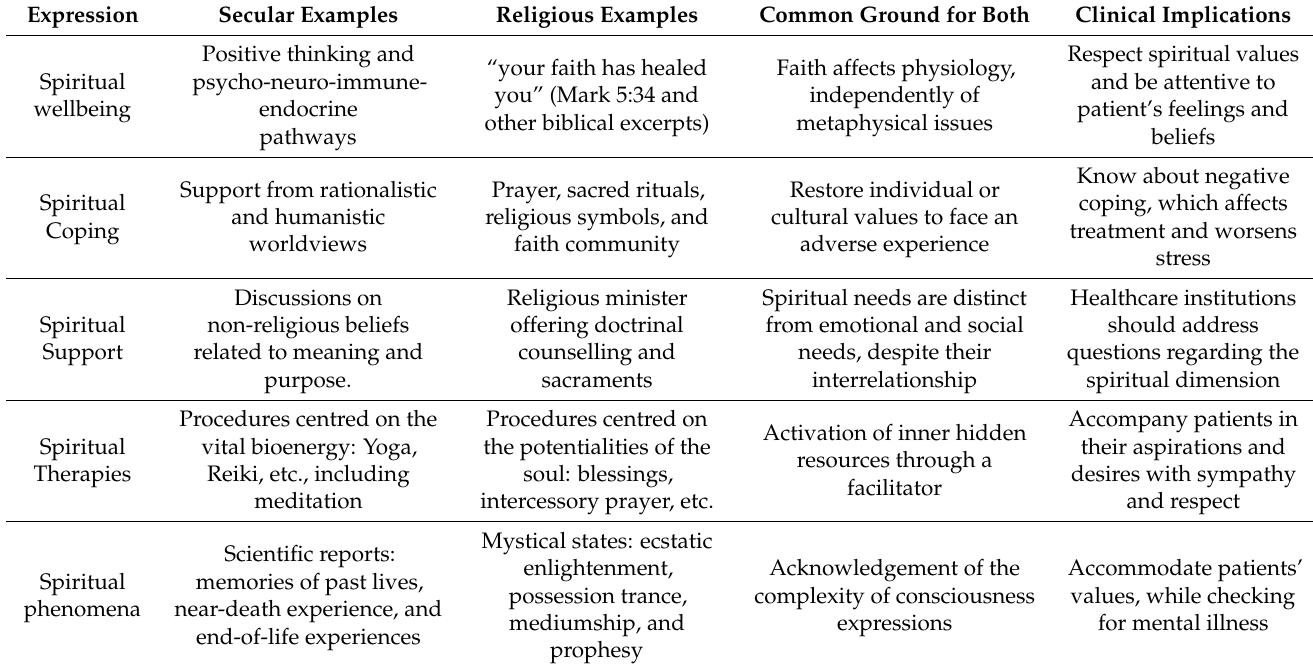
Table 1. Summary of each spiritual expression with its concept, some secular and religious examples, common ground for both, and some clinical